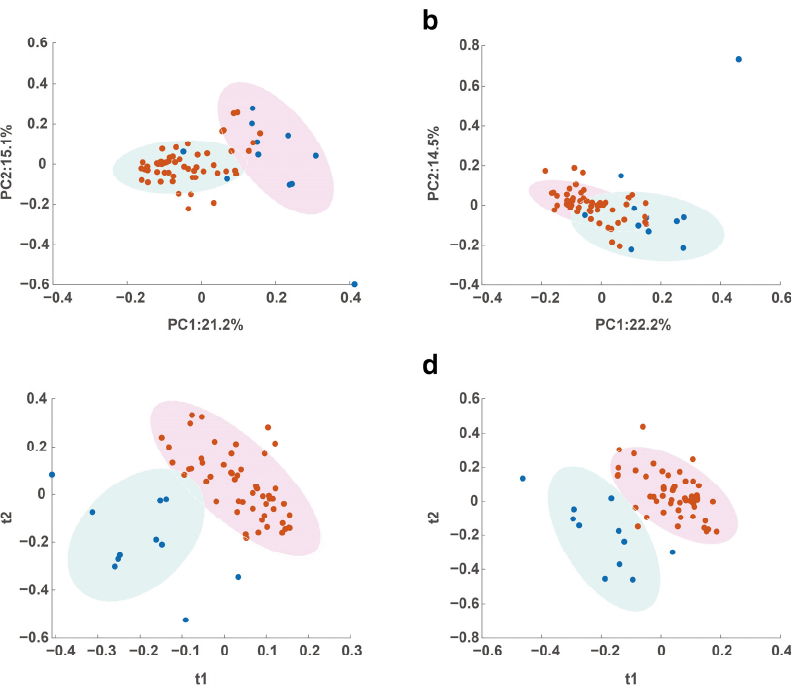
Figure 3. Multivariate analysis of metabolomics distinguishes the oak barrel aged and non-oak barrel aged wines: ( a ) The PCA score plot in the positive ion mode; ( b ) the PCA score plot in the negative ion mode; ( c ) the PLS-DA score plot in the positive ion mode; ( d ) the PLS-DA score plot in the negative ion mode.